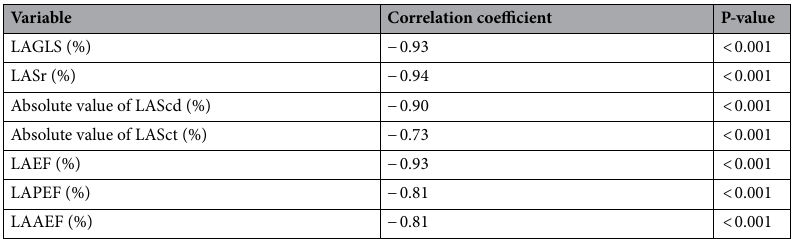
Table 6. Association between the clinical course and LA function parameters in RA patients. LAGLS left atrial global longitudinal strain, LASr left atrial strain during reservoir phase, LAScd left atrial strain during conduit phase, LASct left atrial strain during contraction phase, LAEF left atrial ejection fraction, LAPEF left atrial passive ejection fraction, LAAEF left atrial active ejection